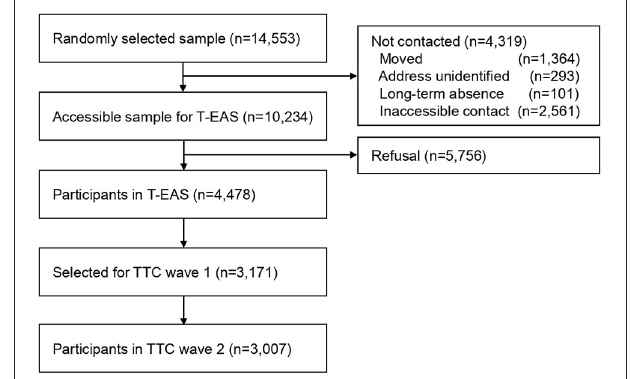
FIGURE 1 | Flowchart of participant